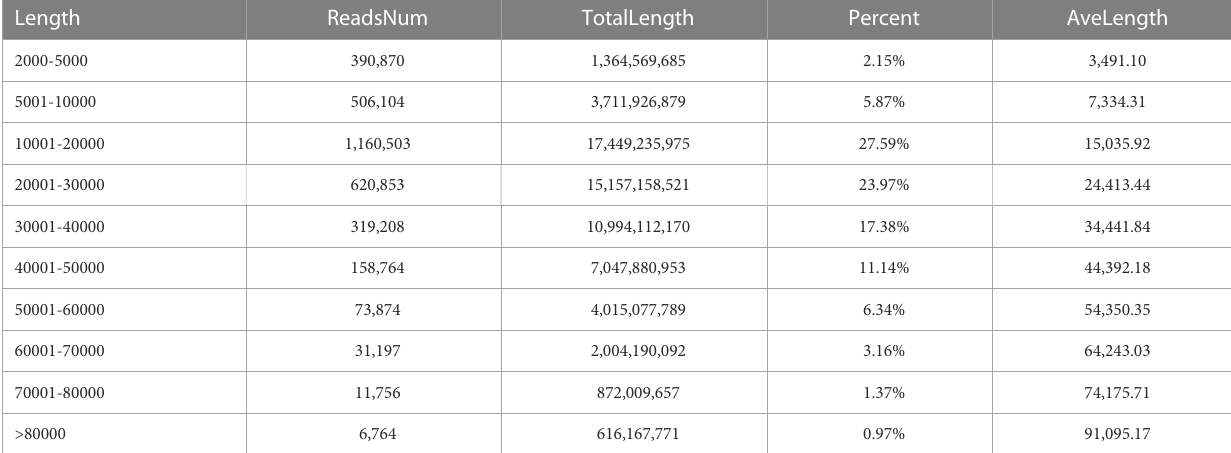
TABLE 1 The Reads length distribution of Nanopore sequencing clean data.